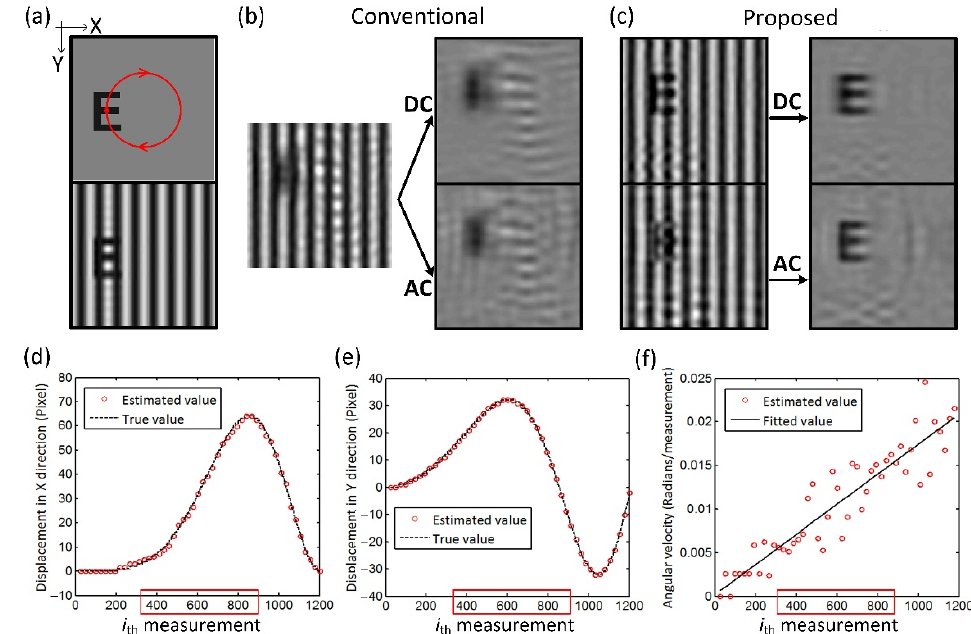
Figure 4. Simulation results of the target in circular motion. ( a ) True target images. Red line and arrows show the moving path and directions of the target. Results (Frame #30) obtained using ( b ) conventional single-pixel SFDI and ( c ) the proposed method. Target displacements in ( d ) X and ( e ) Y directions and ( f ) angular velocities, calculated from motion estimation. The red windows indicate the measurements used for reconstructing Frame #30.